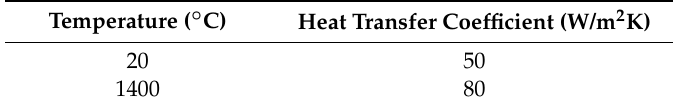
Table A6. Specimen-environment and mold-environment convection heat transfer coefficients.